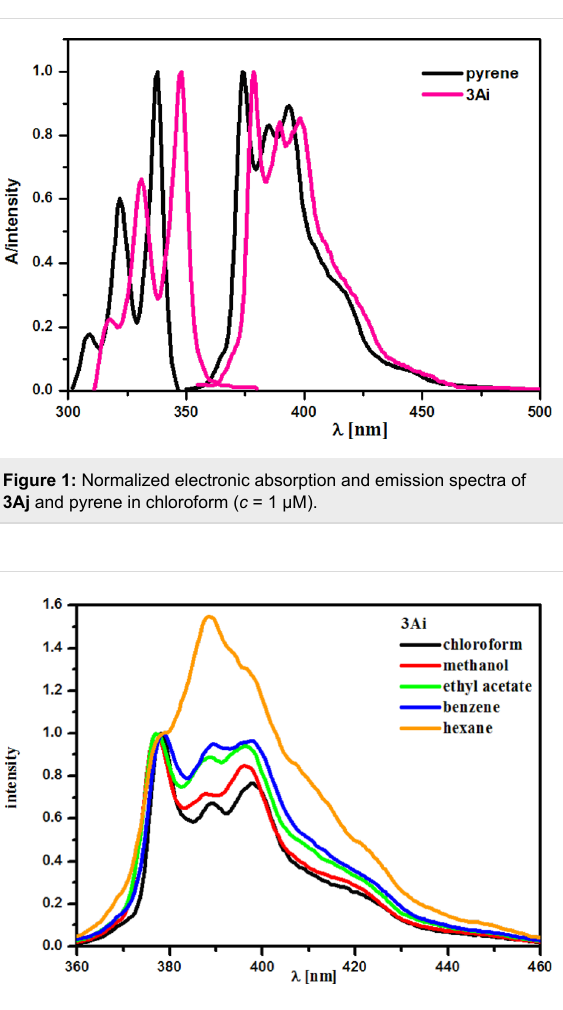
Figure 2: Emission spectra of compound 3Aj in various solvents. The spectra are normalized at ≈ 378 nm (pyrene band